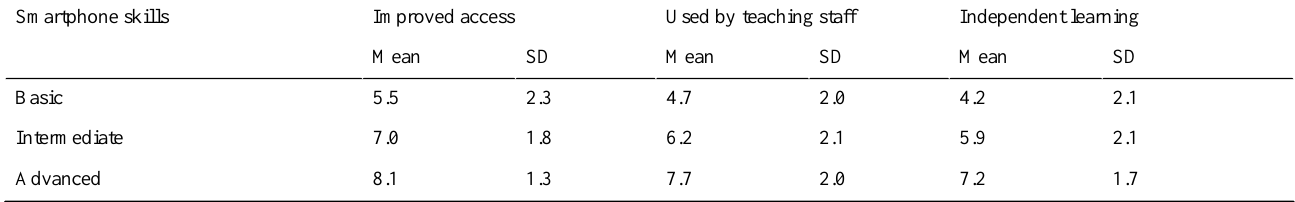
Table 5. Cross tabulation comparing VAS average score of attitudes toward smartphones (improving access to learning material and courses, helping to learn more independently, and use of smartphones by staff) with level of students’smartphones